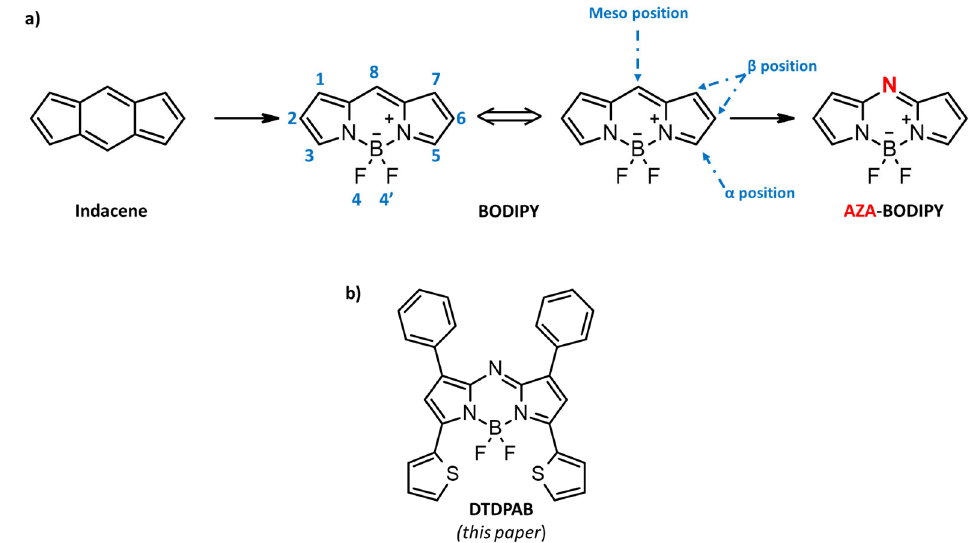
Figure 1. ( a ) From indacene to AZA-BODIPY structure. ( b ) The dithieno-diphenyl-aza-BODIPY ( DTDPAB ) structure.